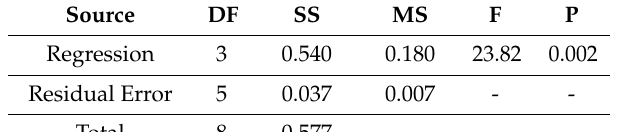
Table 10. Analysis of variance.